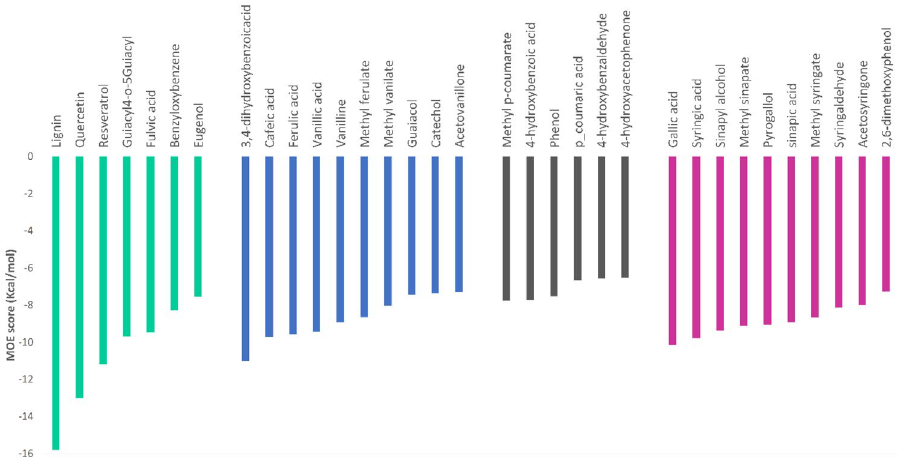
Figure 1. Docking results. Purple – syringyl derivatives of lignin, grey – p-hydroxyphenol derivatives of lignin, blue – guaiacyl derivatives of lignin, green – other potential laccase substrates.